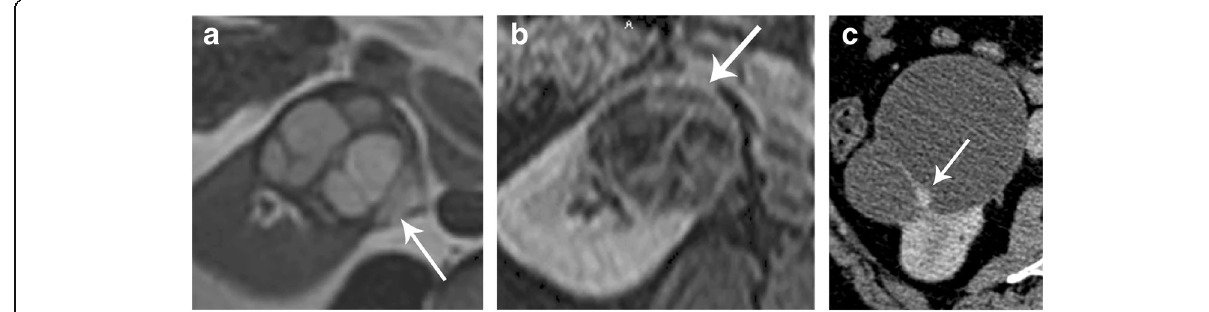
Fig. 16 Bosniak IIIs ( a , b ) and IIIn ( c ) lesions. a Axial T2-weighted MR showing a multiseptated cystic renal lesion (arrow) and ( b ) axial T1 post- contrast MR of the same lesion showing septal enhancement (arrow) consistent with a Bosniak IIIs cyst. c Axial contrast-enhanced CT of a cystic renal mass with septae nodularity (arrow) considered to be a Bosniak IIIn cyst